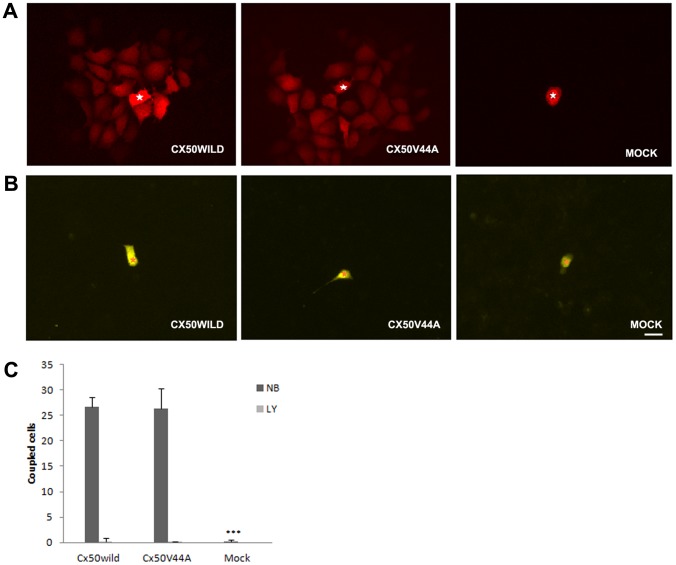
Dye transfer assay in HeLa cells stably transfected with Cx50WILD and Cx50V44A.A: Cx50WILD- and Cx50V44A-transfected cells displayed extensive transfer of neurobiotin, whereas the pEGFP-N1-transfected cells did not allow transfer of this tracer. The white stars show the injected cells. (B) Neither cell line showed significant intercellular transfer of Lucifer yellow. The orange stars show the injected cells. Scale bar: A-B 20 µm. (C) The number of three groups of cells absorbing neurobiotin (NB) and lucifer yellow (LY) from the injected cell. Data are presented as mean±SDs; n = 20; the neurobiotin transfer assay showed significant differences in the percentage of coupled cells between the control group and the Cx50WILD/Cx50V44A groups (P<0.001, marked with ***).